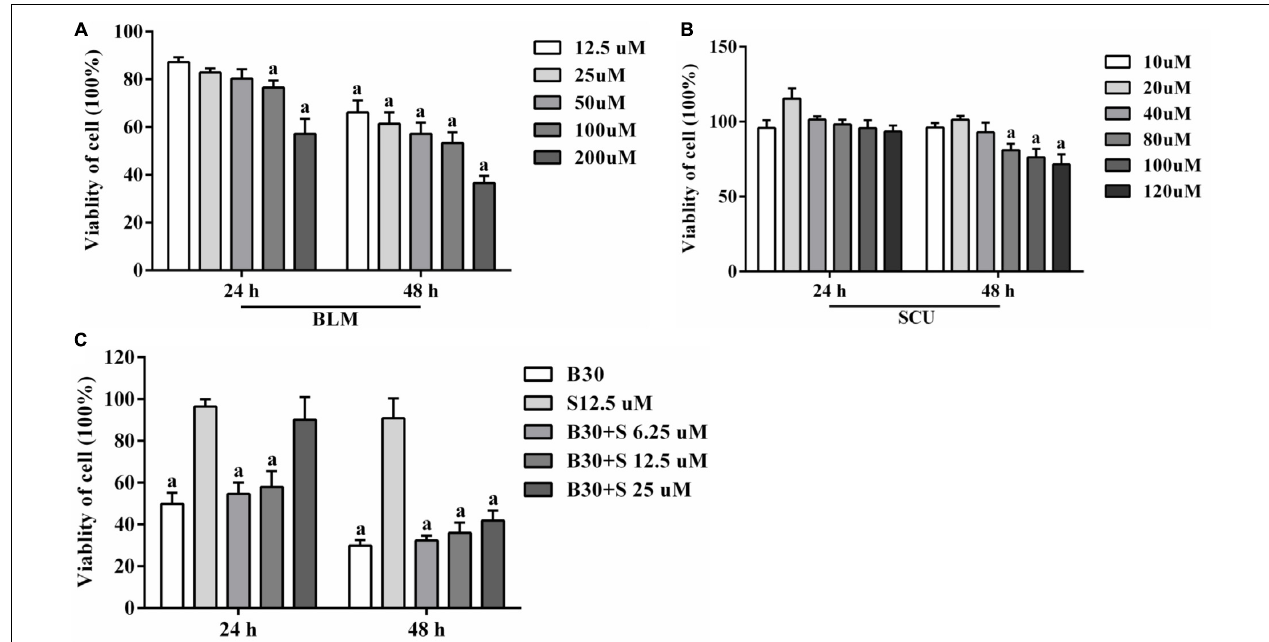
FIGURE 6 | Effects of BLM, SCU, and their combination on the viability of MRC-5 cells. (A) The viability of MRC-5 cells after 24 and 48 h treatment of BLM alone. (B) The viability of MRC-5 cells after 24 and 48 h treatment of SCU alone. (C) The viability of MRC-5 cells after 24 and 48 h treatment of BLM combined with SCU. The data of the control group were pegged as 0.0%, whereas other data were calculated relative to it. Data are shown as the mean ± SD. ( n = 5). a < 0.05 compared with control group.